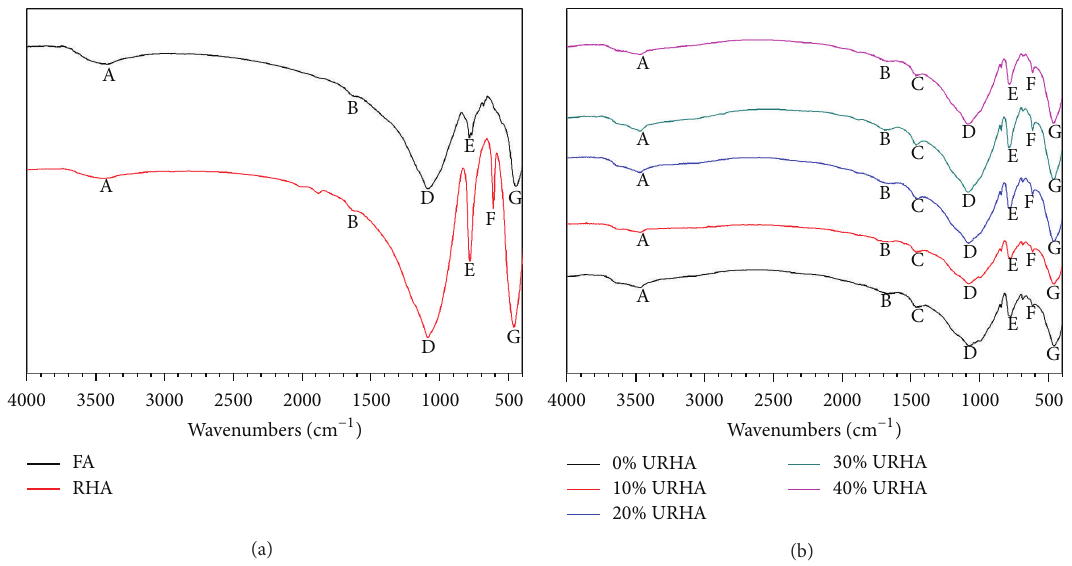
Figure 8: FTIR spectra of (a) the FA and RHA powders and (b) the brick specimens prepared with various URHA replacement